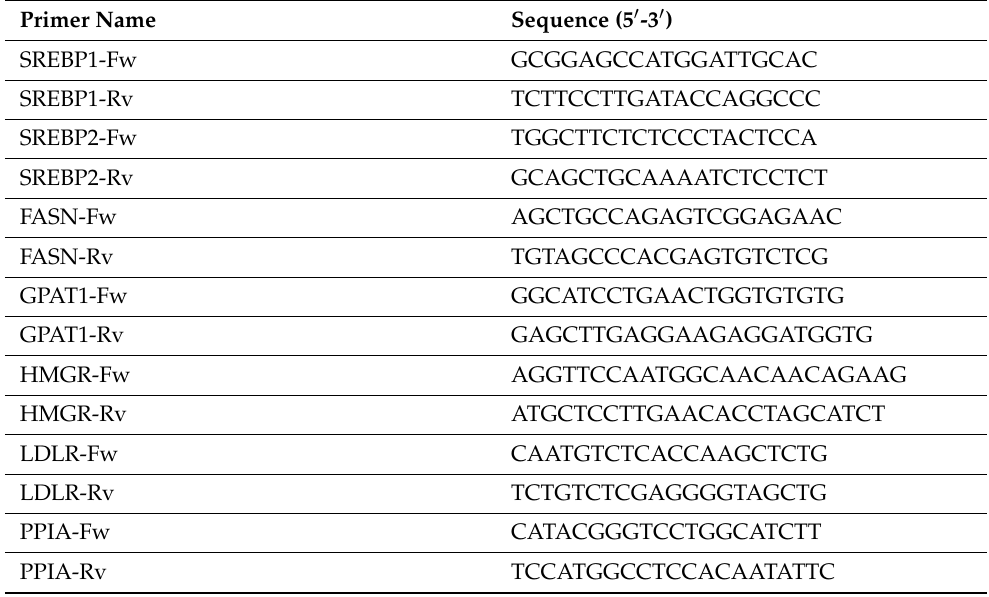
Table 1. qPCR primers